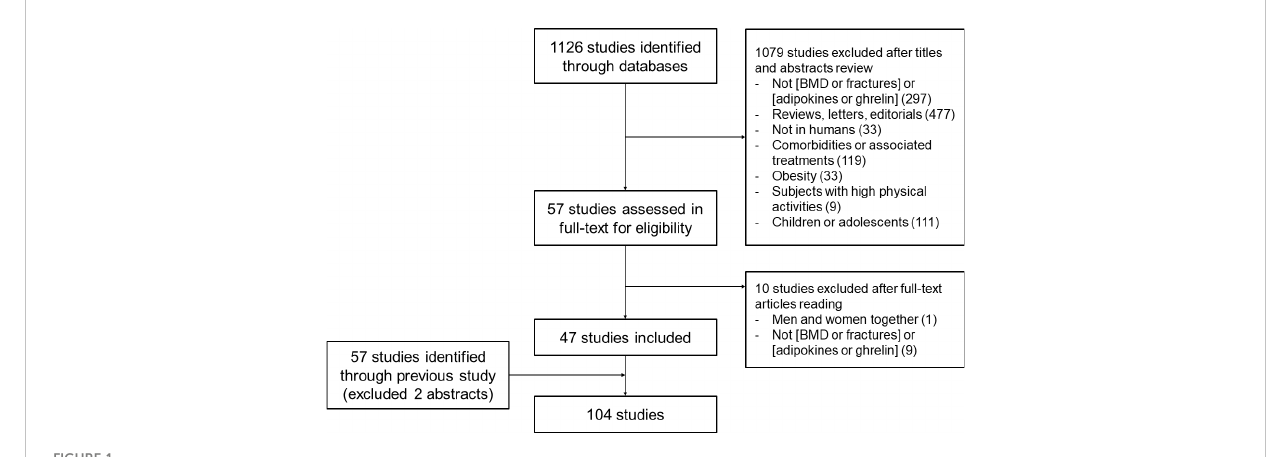
FIGURE 1 Flow chart depicting the search strategy employed to determine eligible